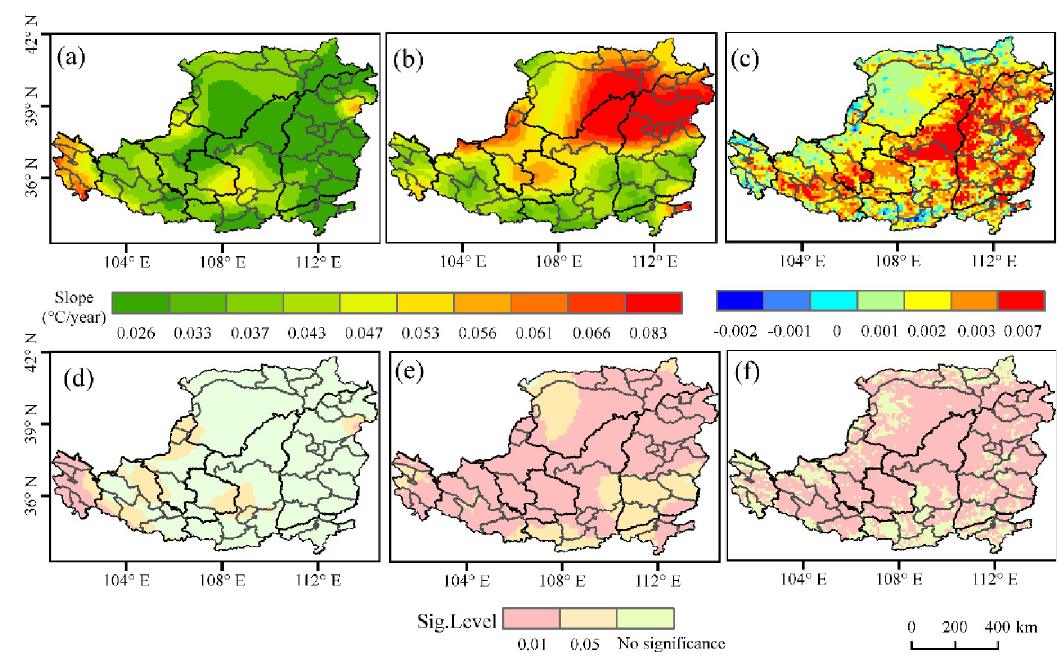
Fig 4. Trends of T max / T min and NDVI in autumn over the Loess Plateau from 1982 to 2015. (a) the slope of T max ; (b) the slope of T min ; (c) the slope of NDVI; (d) the significance level of T max trends; (e) the significance level of T min trends; and (f) the significance level of NDVI